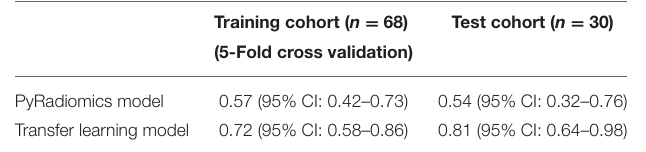
TABLE 2A | Summary of models’ performances in AUC.